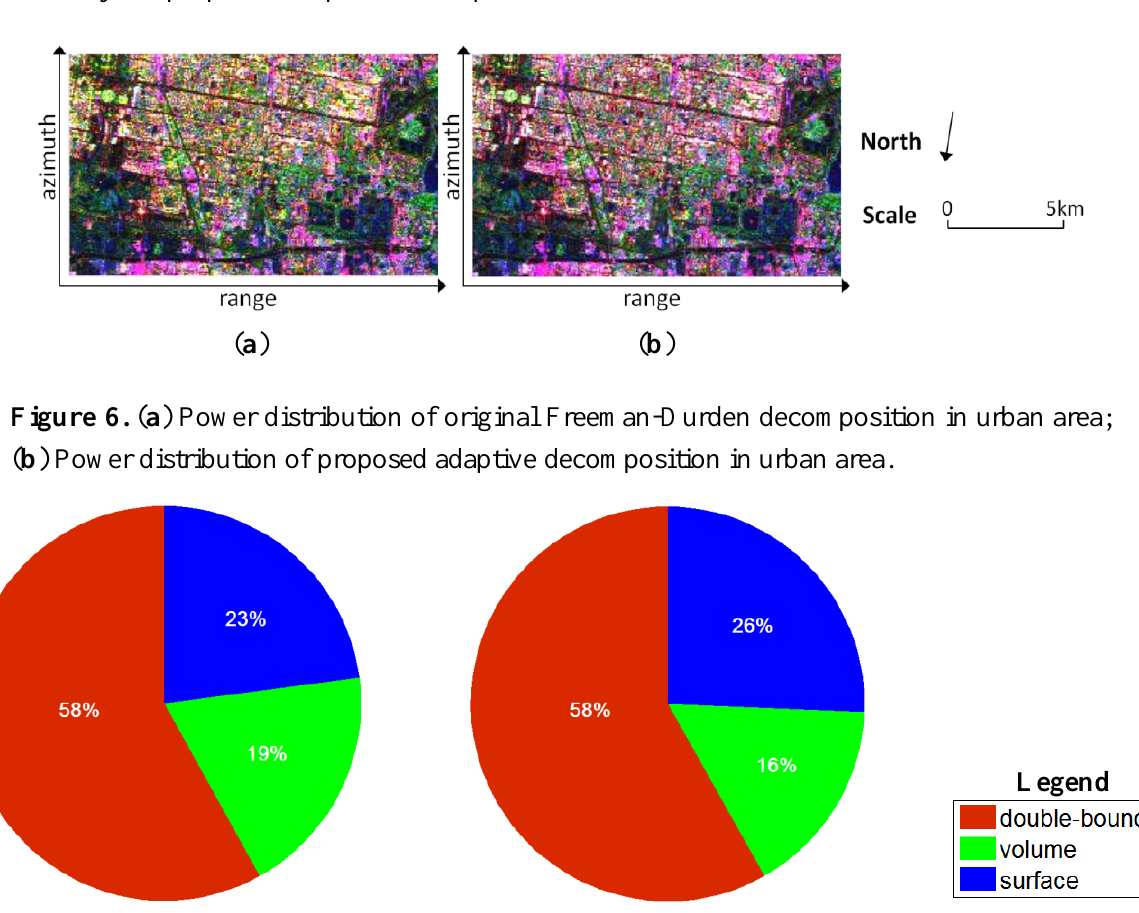
Figure 5. ( a ) Zoomed result by the original Freeman-Durden decomposition; ( b ) Zoomed result by the proposed adaptive decomposition